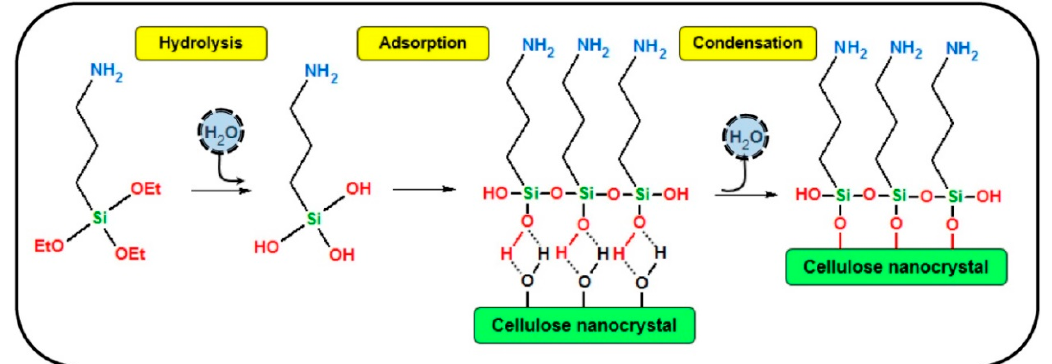
Figure 8. Reaction scheme between 3-aminopropyltriethoxysilane (APTES) and cellulose nanocrystals (CNC) in the presence of water. Reproduced from [53] with permission from Elsevier and Copyright Clearance Center, 2018.